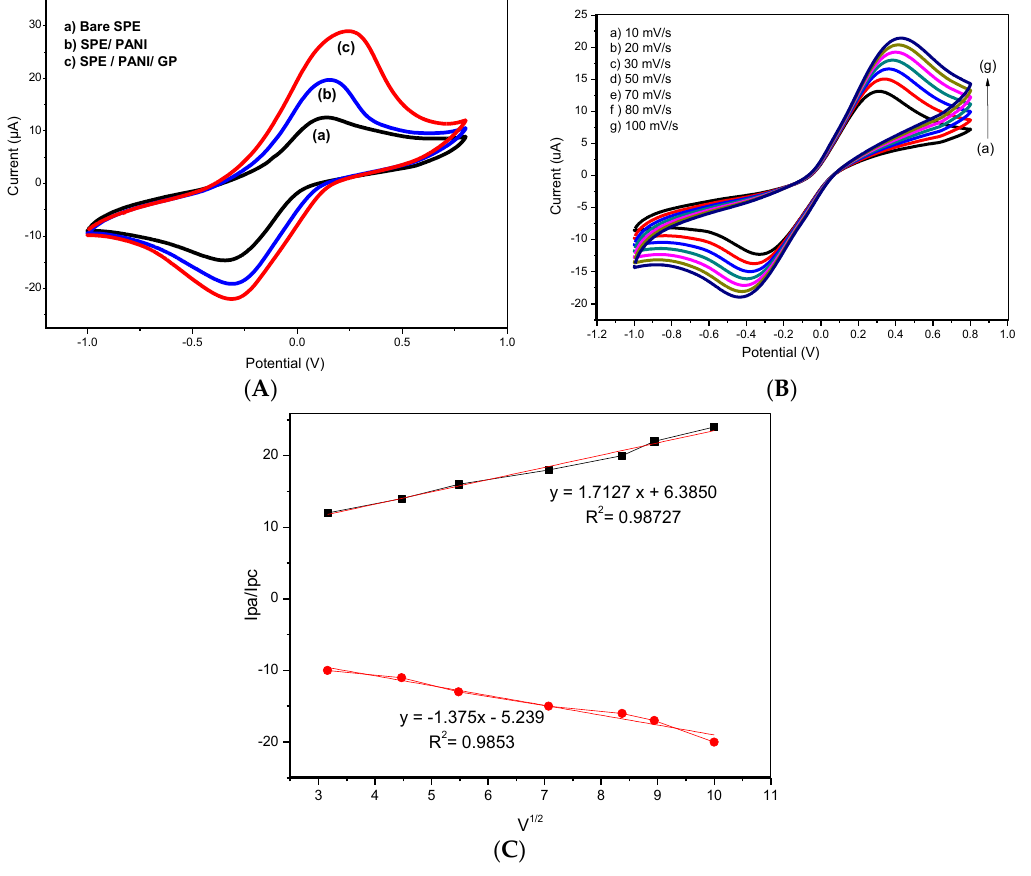
Figure 8 . ( A ) Cyclic voltammograms of ( a ) bare SPCE ( b ) SPCE/PANI ( c ) SPCE/PANI/GP recorded in 5.0 mM Fe(CN) 63−/4− solution containing 0.1 M KCl at100 mV·s −1 ; ( B ) Cyclic voltammograms of